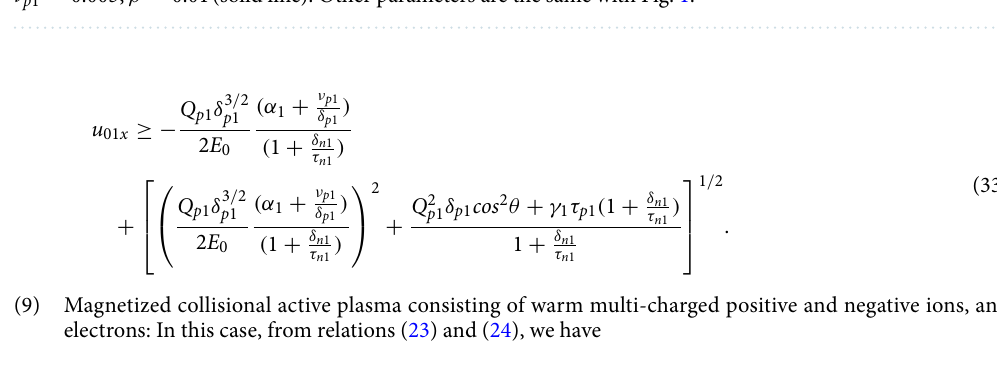
Figure 2. Variation of the normalized ( a ) electric potential and ( b ) net space-charge toward the wall for ν p 1 = 0, ρ = 0 (dotted-dashed line), ν p 1 = 0, ρ = 0.01 (dotted line), ν p 1 = 0.005, ρ = 0 (dashed line) and ν p 1 = 0.005, ρ = 0.01 (solid line). Other parameters are the same with Fig.